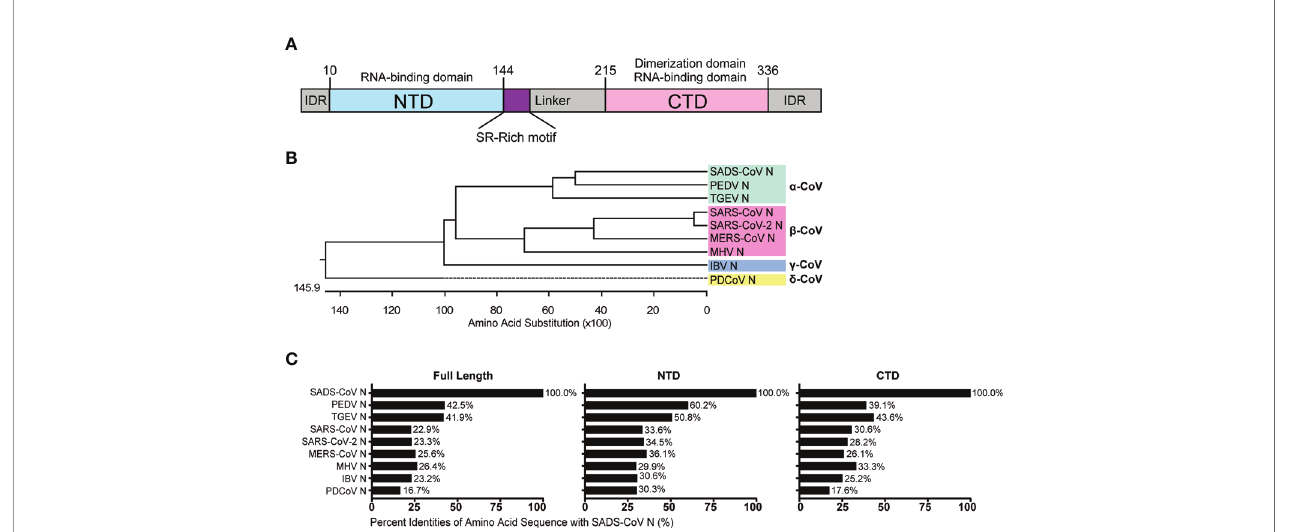
FIGURE 1 | Amino acid sequence similarity between the N proteins of SADS-CoV and other members of the Coronavirinae. (A) Schematic representation of SADS- CoV N protein domains. Three intrinsically disordered regions (IDR), the N-terminal domain (NTD) and C-terminal domain (CTD) are shown. The charged Ser/Arg (SR)-rich motif (coloured purple) is shown. (B) Phylogenetic analysis of N proteins of representative coronaviruses from each genus. (C) The alignment was conducted by clustalW X, and the fi gure was generated by GraphPad Prism 7.0 according to the similarity calculated by DNASTAR